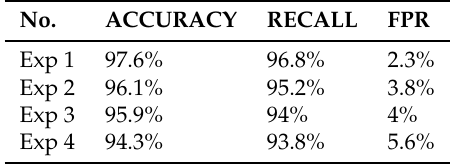
Table 5. Comparison result